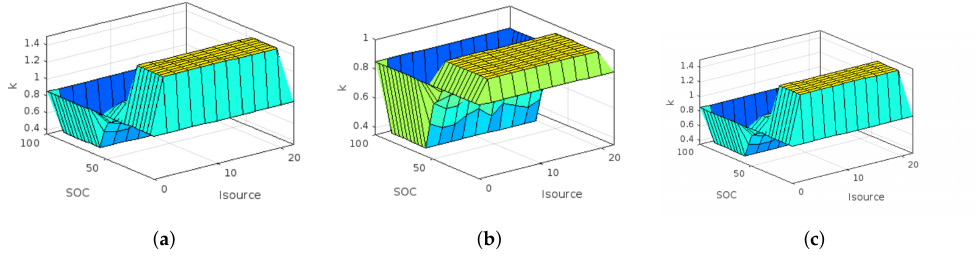
Figure 12. Three-dimensional view ( a ) at k1, ( b ) at k2, and ( c ) at